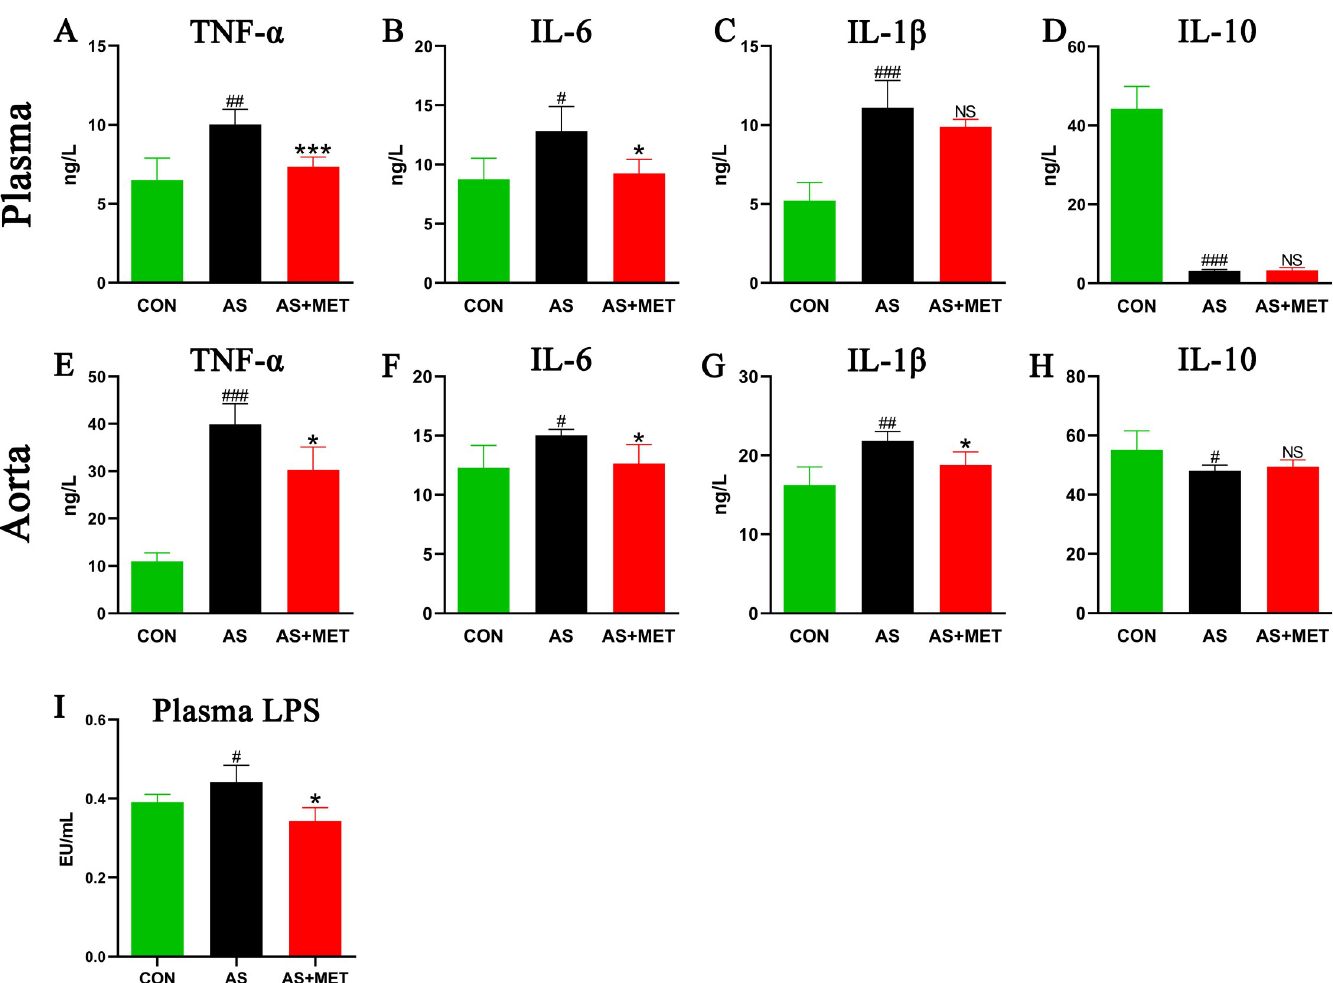
Fig 3. Determination of plasma and aorta inflammatory cytokine levels in different groups. Plasma and aorta tissues of mice from three groups were respectively collected for the determination of tumor necrosis factor (TNF)- α ( A, E ); interleukin (IL)-6 ( B, F ); IL-1 β ( C, G ) and IL-10 ( D, H ) concentrations using a flow cytometric bead array (CBA) kit. ( I ) Plasma lipopolysaccharide (LPS) levels in diverse groups were determined using a Limulus amebocyte lysate kit. # (CON vs. AS): # p < 0.05, ## p < 0.01, ### p < 0.001. � (AS vs. AS+MET): � p < 0.05, �� p < 0.01, ��� p < 0.001. NS, no significant difference.